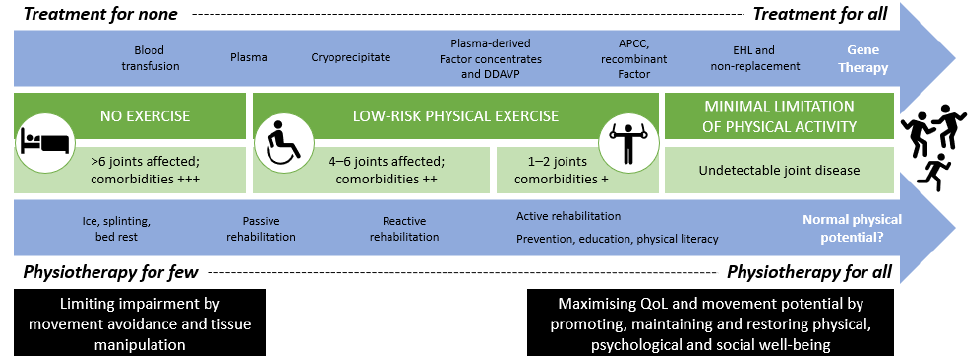
Figure 2. Timeline of physiotherapy adaptations within the haemophilia landscape. There has been a growing scope for physiotherapy and physical activity alongside increasingly effective medical management options. APCC, activated prothrombin complex concentrate; DDAVP, desmopressin; EHL, extended half-life products; QoL, quality of life.